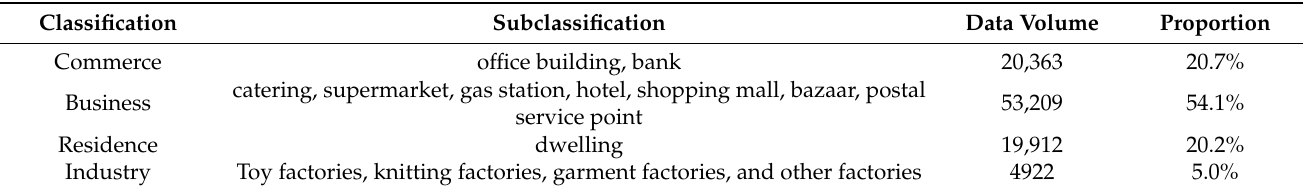
Table 2. Classification of POI